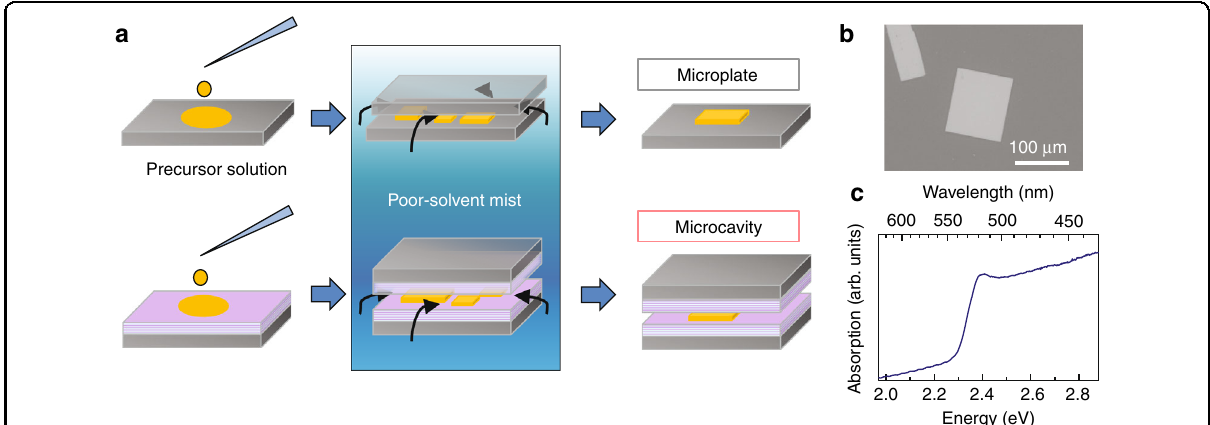
Fig. 2 Space-limited antisolvent vapor-assisted crystallization method for CsPbBr 3 single-crystal microplate, and microcavity fabrications. a Schematics for preparing microplate (upper row) and microcavity (lower row) with the antisolvent vapor-assisted method. Perovskite precursor solution is prepared by solving CsBr and PbBr 2 powders into DMSO. ACN is used as poor solvent mist. b A scanning electron microscopic image of CsPbBr 3 microplates. c Absorption spectrum of bare microplate near the band